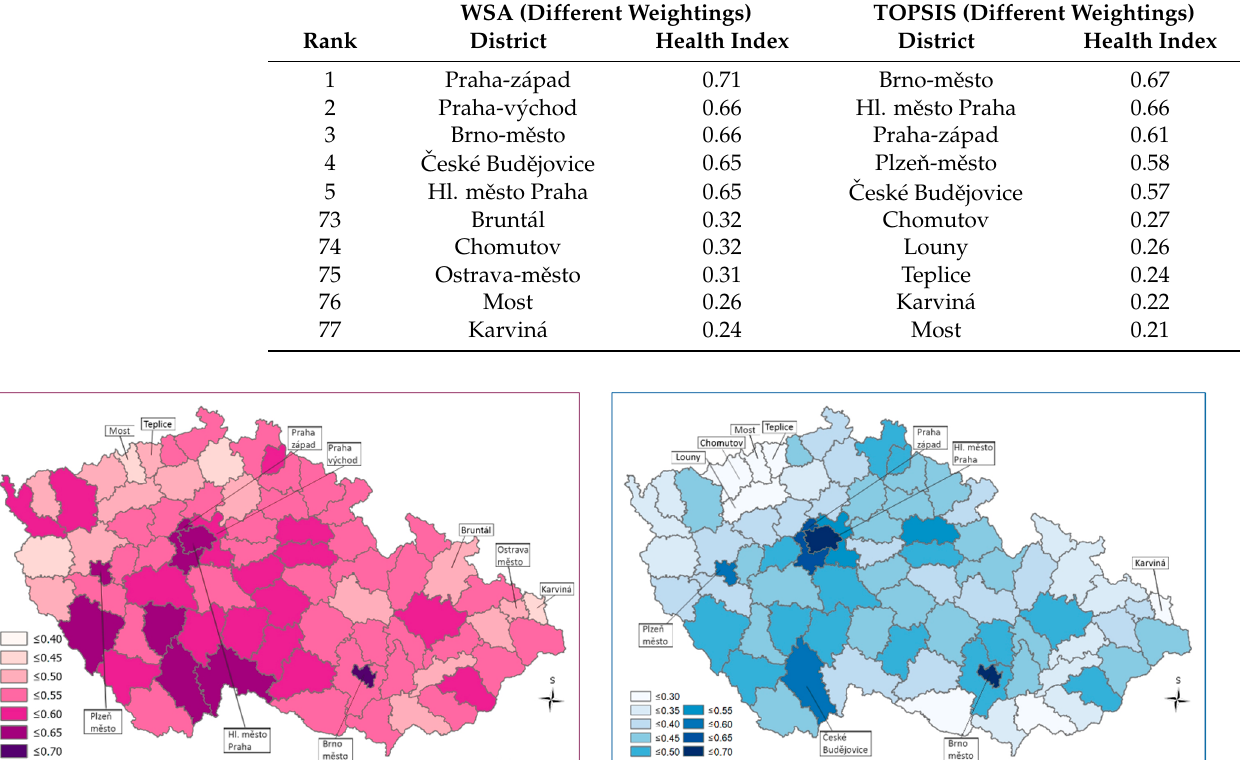
Table 3. Health index, WSA, and TOPSIS method, different weightings of areas (selection of the best and worst five districts of the Czech Republic).